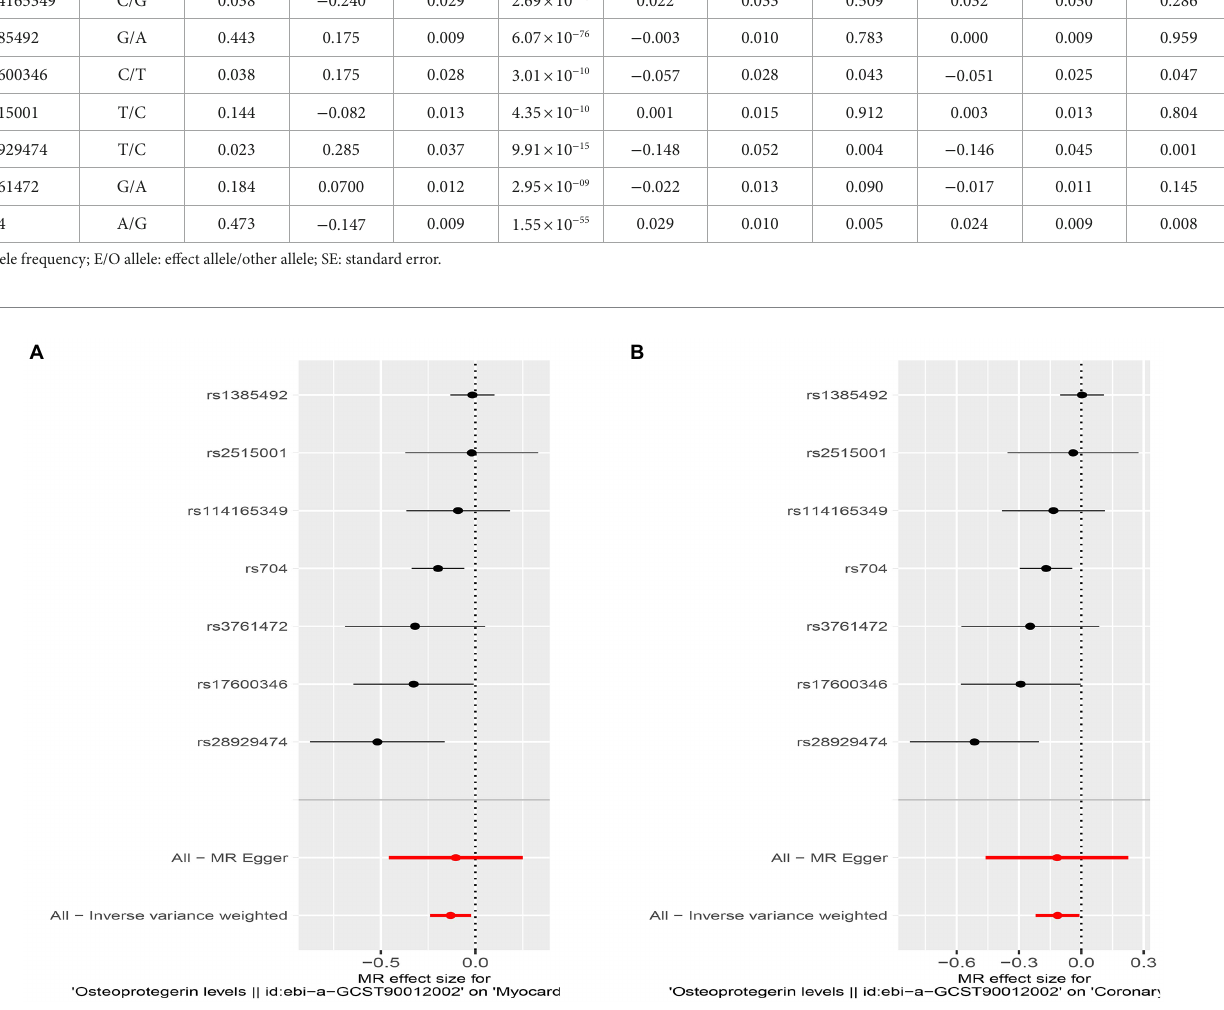
FIGURE 4 Results of the SNP analyses for the SNP effect of plasma OPG level on outcomes. (A) AMI (B)